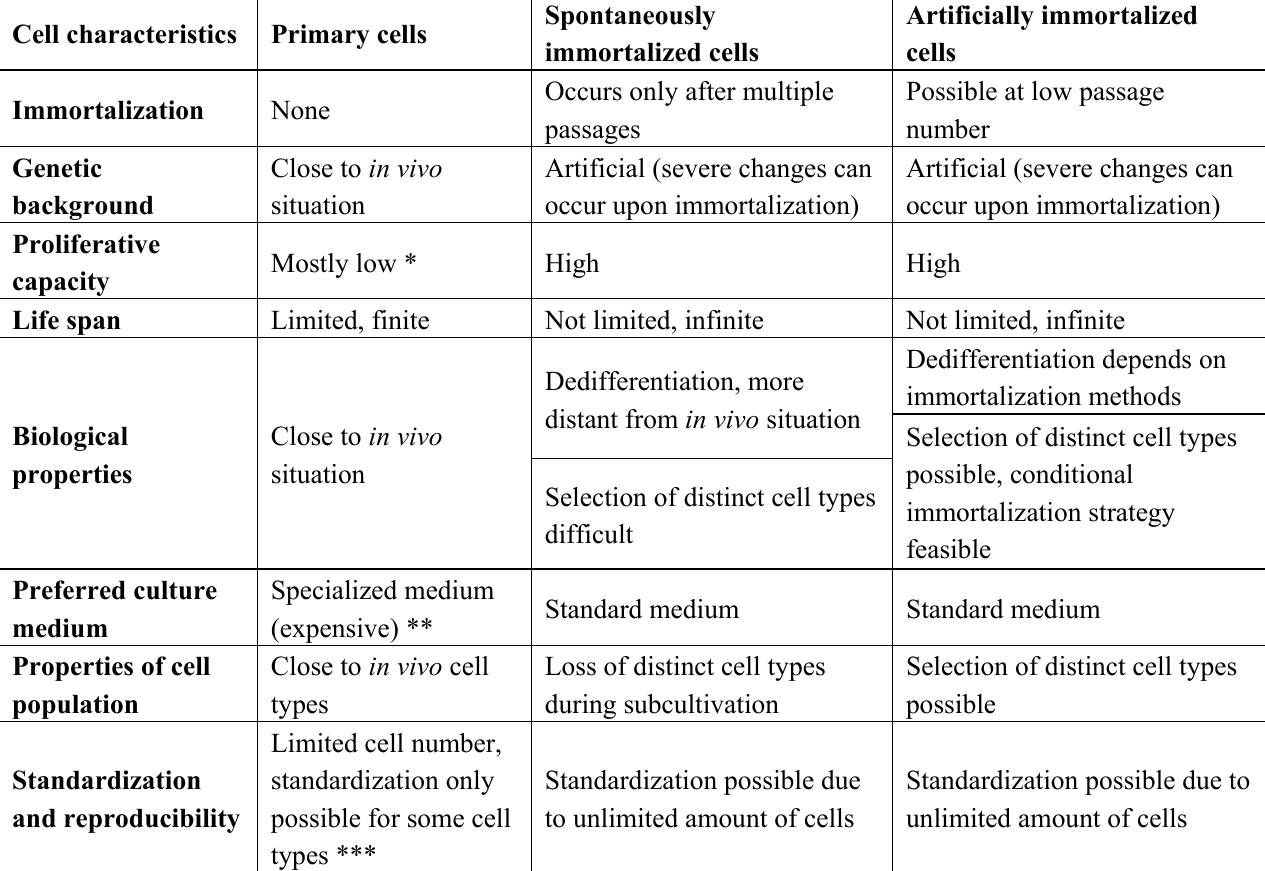
Table 2. Advantages and disadvantages of primary vs. spontaneously vs. artificially immortalized cell